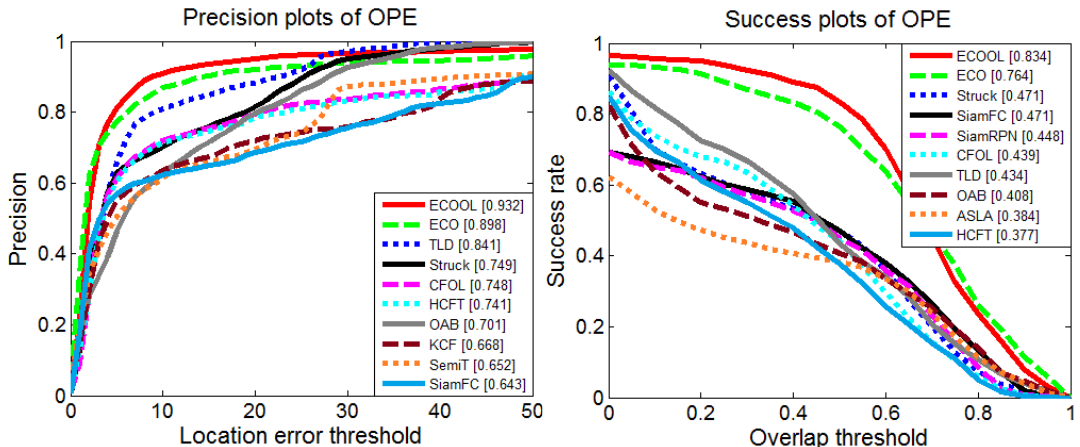
Figure 15. Quantitative comparison of the tracking performance.